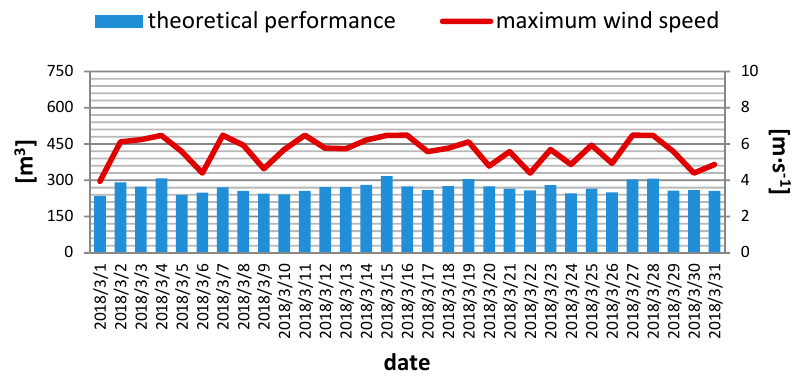
Figure 4. Efficiency of the pulverization unit of the aerator in March.